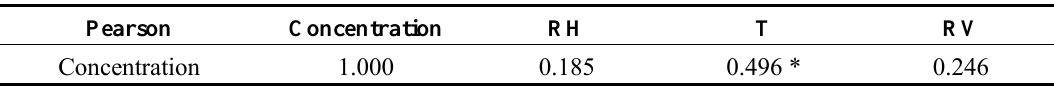
Table 3. Pearson correlation coefficients between concentrations of airborne fungi and meteorological factors during sampling ( n =